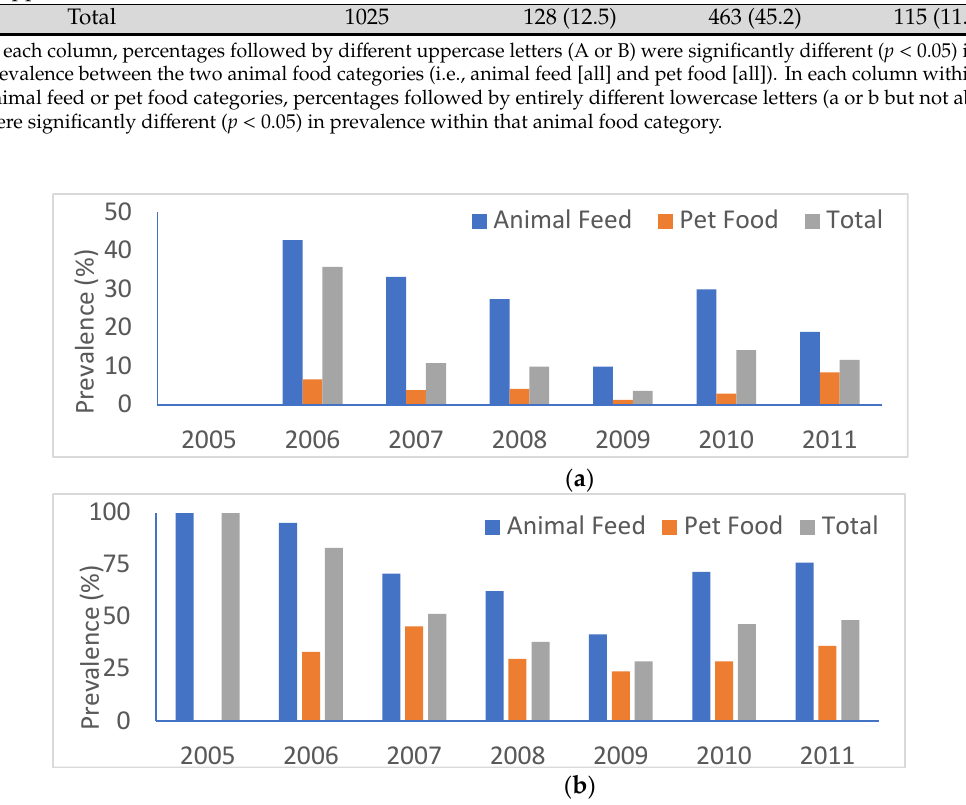
Figure 1. Prevalence of E. coli and Enterococcus spp. by year and animal food category. ( a ) E. coli ; ( b ) Enterococcus spp.